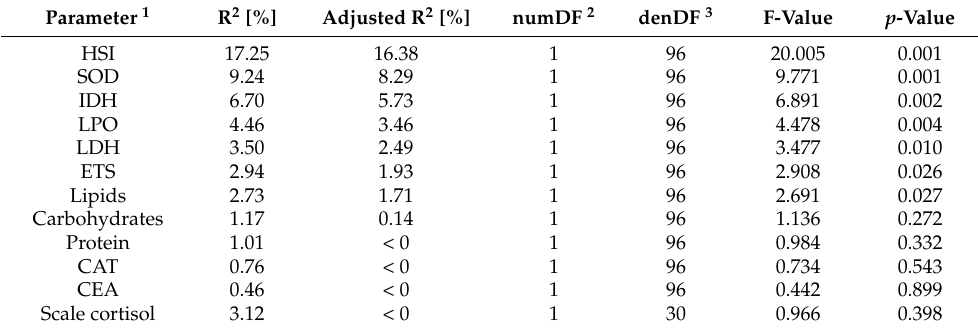
Table 3. RDA using individual biomarkers as predictors for gut microbiome